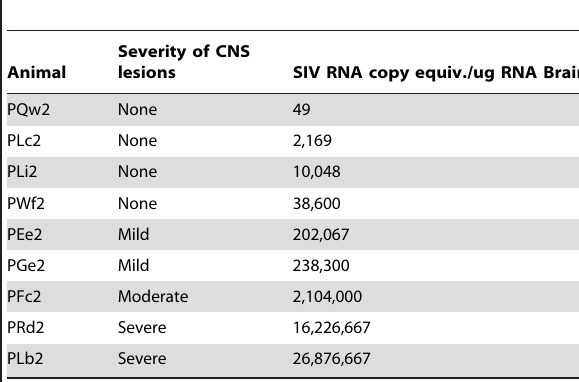
Table 3. Severity of CNS Lesions and SIV RNA in Brain at 42 days P.I.